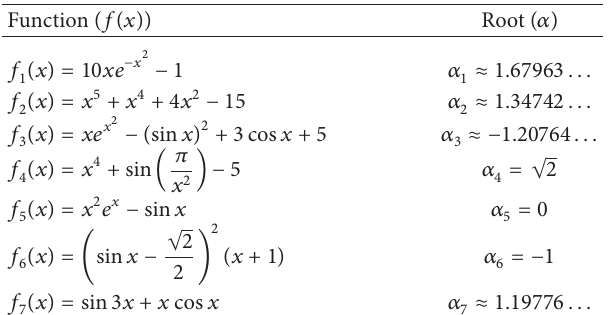
Table 1: Functions and their